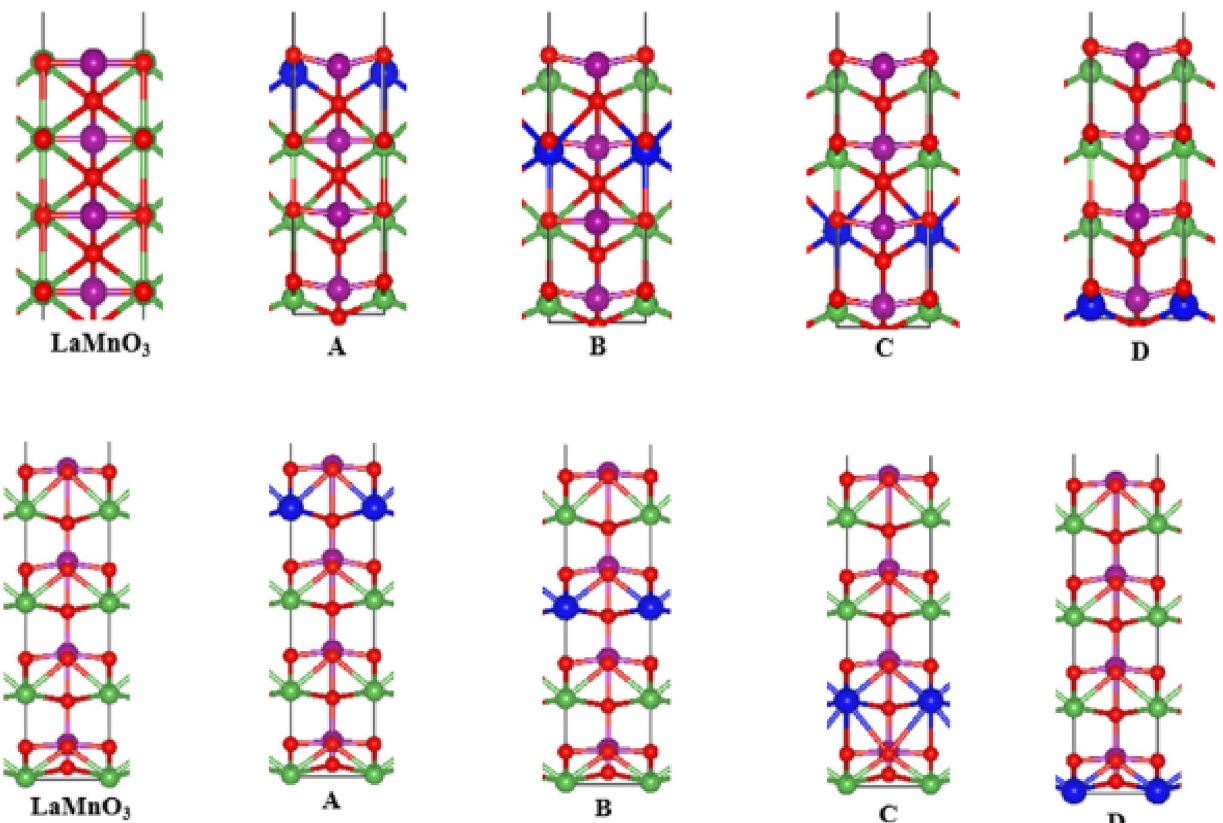
Fig. 1 (Top) A is BaMnO-terminated and B–D are LaMnO-terminated {110} surface models. (Down) MnO Color code: green = La, blue = Ba, purple = Mn, and red = O